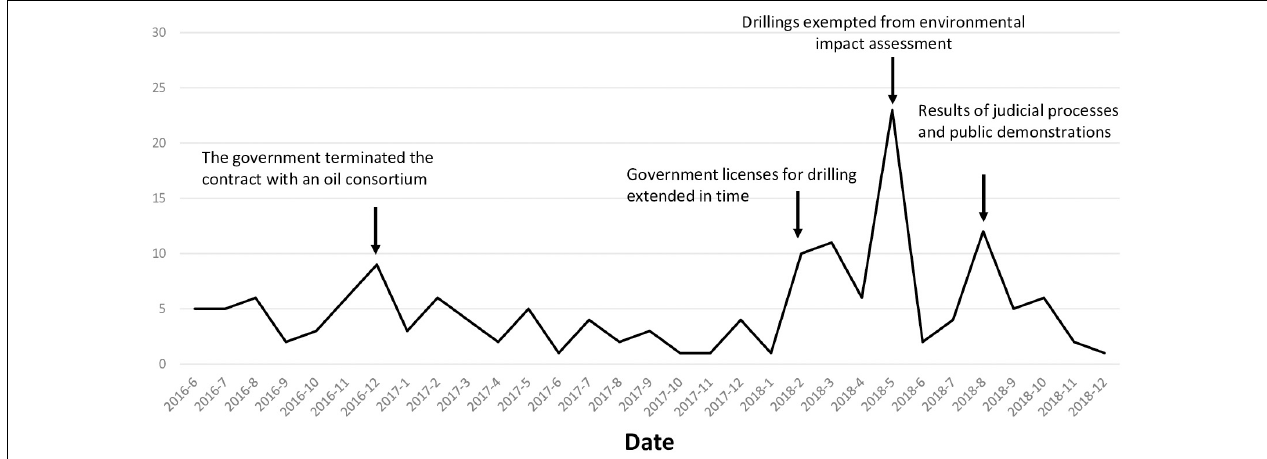
FIGURE 1 | Variation in the number of news about offshore drilling in Portugal in “Público” and “Correio da Manhã” between June 2016 and December 2018.